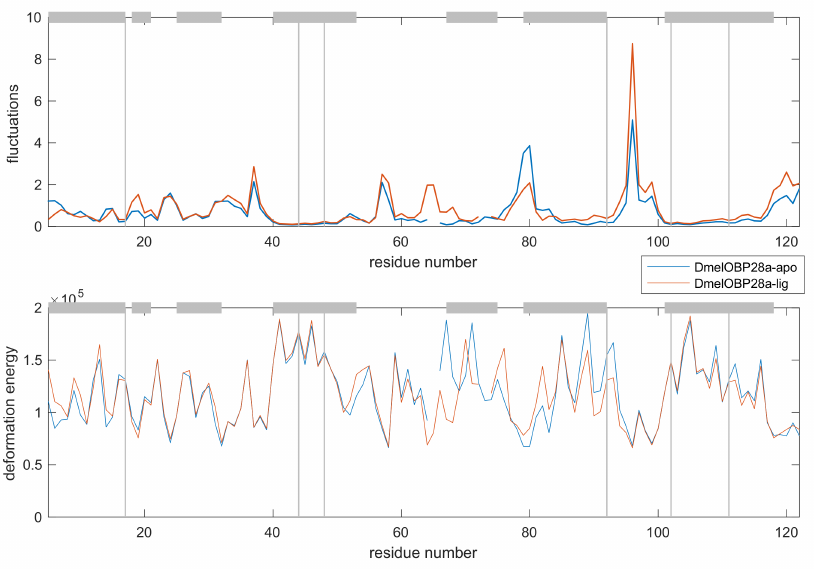
Figure A3. Fluctuation and deformation energy profiles of AgamOBP22 in ligand-free and ligand- bound conformations.